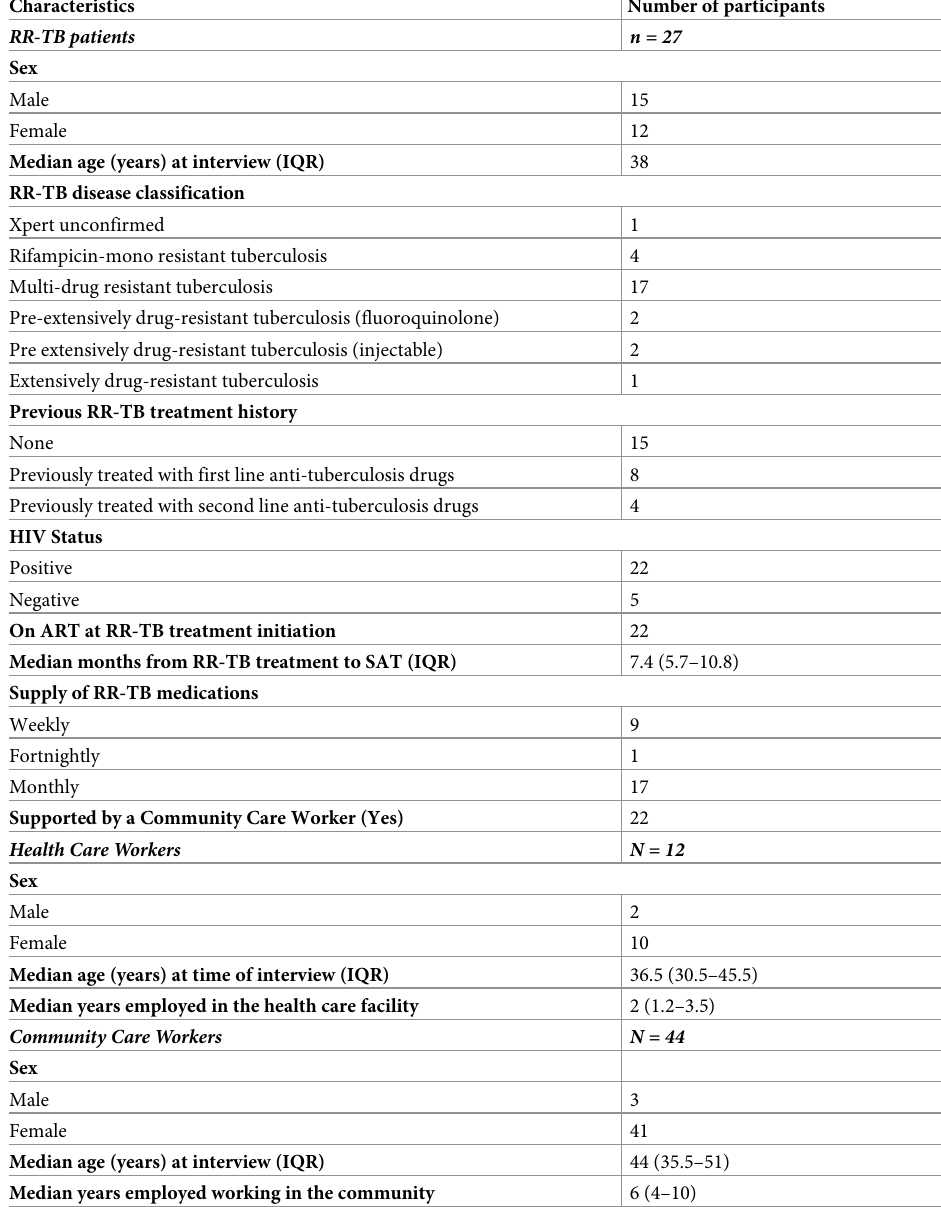
Table 1. Clinical and demographic characteristics of enrolled patients.